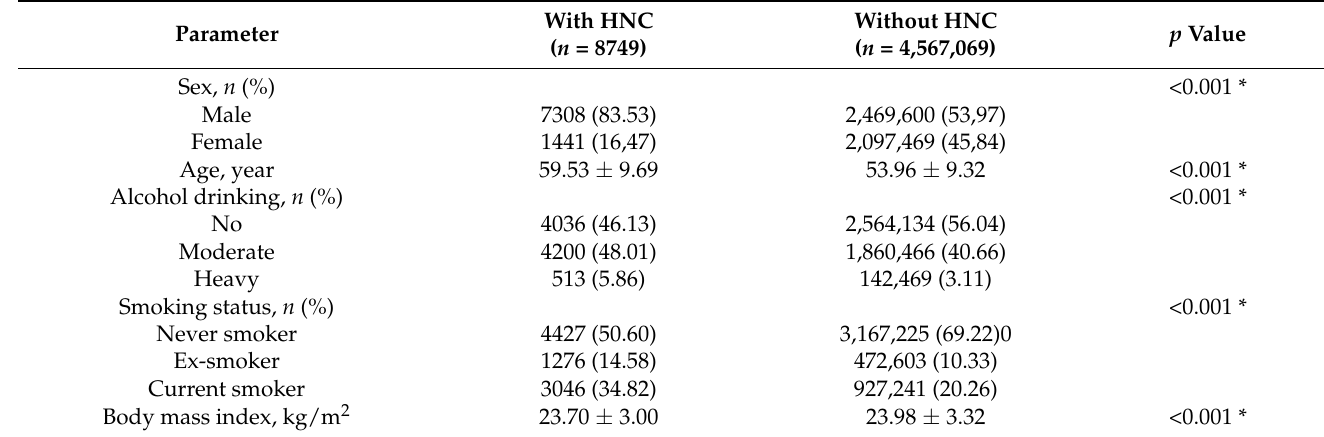
Table 1. Analysis of factors potentially associated with head and neck